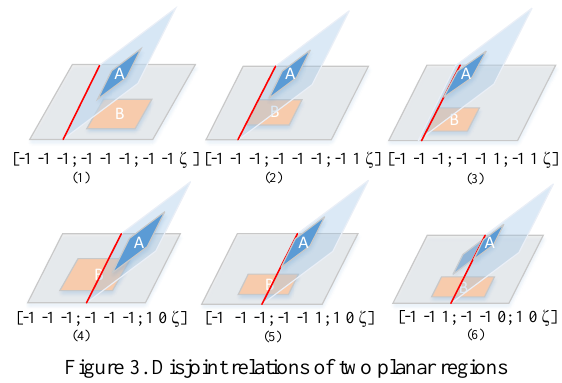
Figure 1. Disjoint case between line segments resulted from the intersection of two planar regions and intersecting line of two